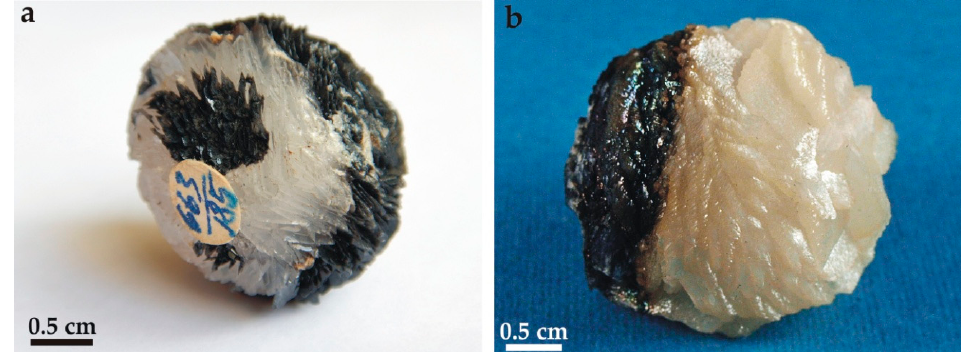
Figure 11. Twin black calcite spheres and related jamesonite “wool” from Herja. a ) Twin black calcite spheres with more abundant jamesonite preserved in the junction zone; sample RCol/2/Q, MMBBU. b ) Twin black calcite spheres formed of flattened calcite rhombohedra associated to jamesonite and covered by siderite minute crystals and attached spheres; sample RCol/2/S;